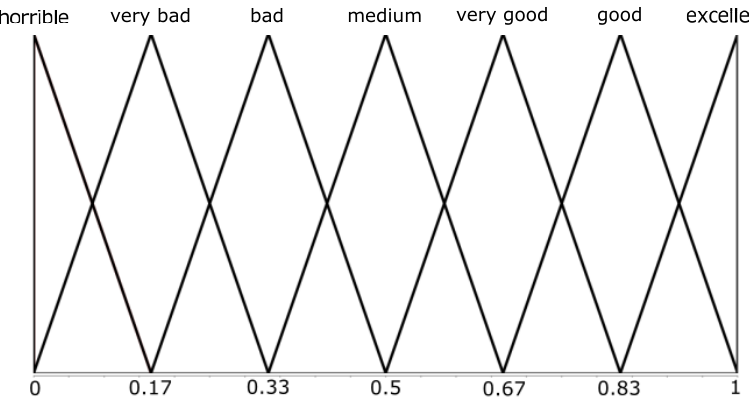
Figure 6. Expression domain.